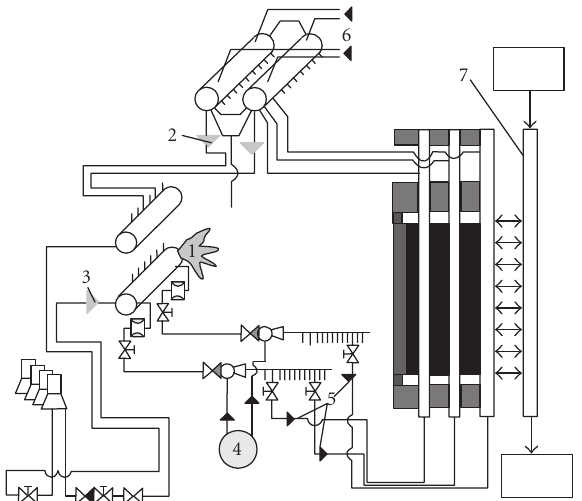
Figure 12: MCP pressure header break with failure of ECCS (except ECCS hydro accumulators): (1) pressure header break; (2) discharge of coolant from drum separators in the a ff ected loop; (3) discharge of coolant from lower part of reactor cooling circuit in the a ff ected loop; (4, 5) supply of water from ECCS hydroaccumulators; (6) supply of steam from DSs in in the intact loop; (7) circuit for cooling of rods in reactor control and protection system.